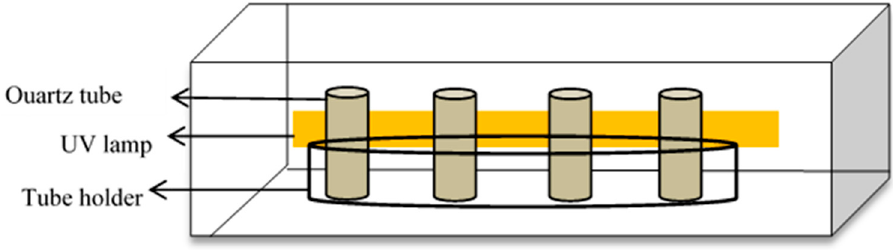
Figure 1. The photocatalytic reactor used in this study.